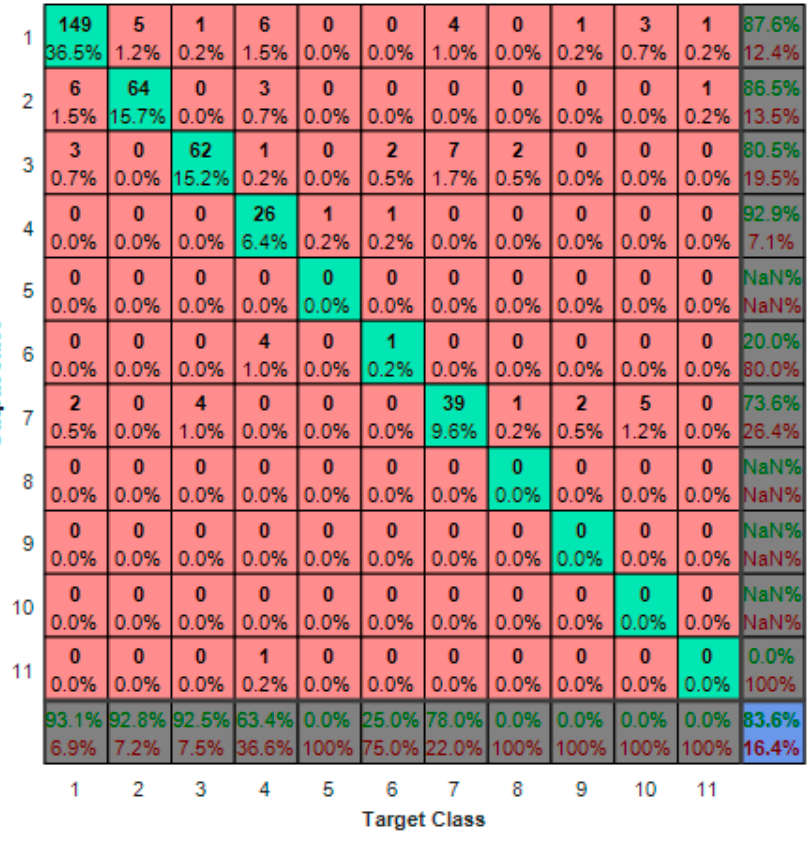
Figure 12. Confusion matrix of classification result.